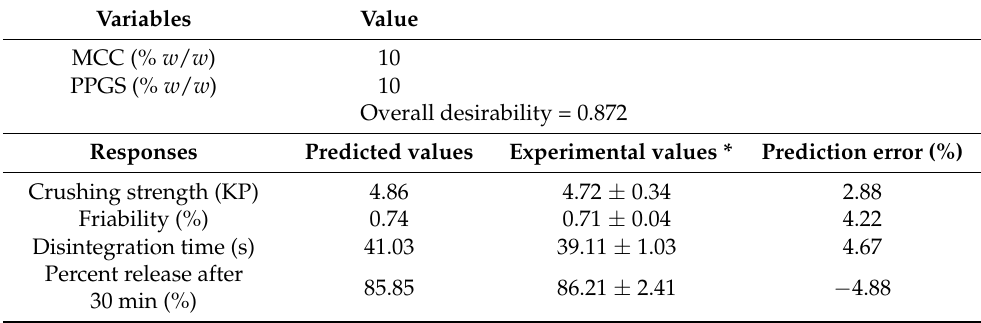
Table 11. Predicted and experimental values of optimized run with their relative errors. Variables Value MCC (% w / w ) 10 PPGS (% w / w ) 10 Overall desirability = 0.872 Responses Predicted values Experimental values * Prediction error (%) Crushing strength (KP) 4.86 Friability (%) Disintegration time